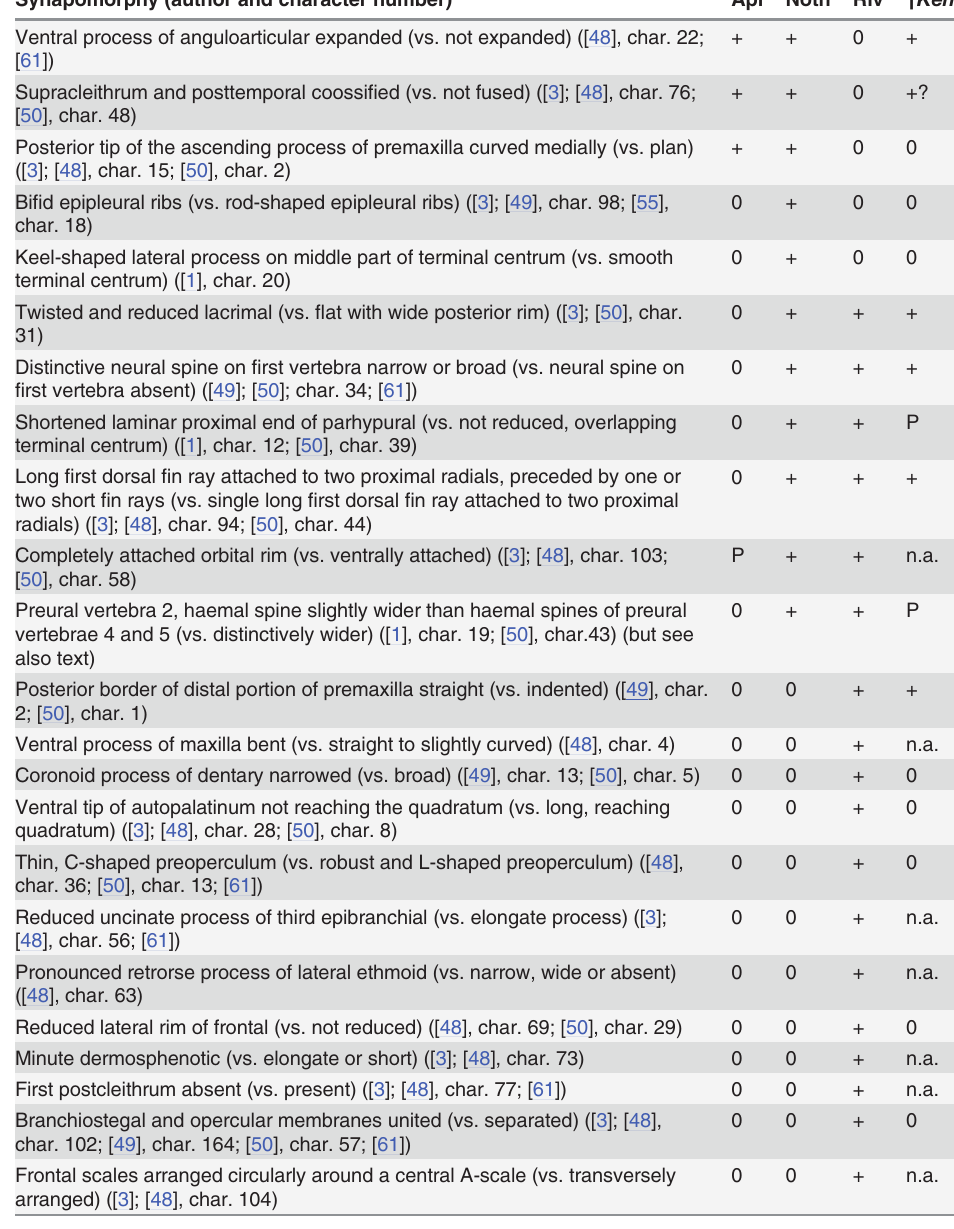
+ + 0 + + + 0 +? + + 0 0 0 + 0 0 0 + 0 0 0 + + + 0 + + + 0 + + P 0 + + + P + + n.a. 0 + + P 0 0 + + 0 0 + 0 0 0 + 0 0 0 + n.a. 0 0 + n.a. 0 0 + 0 0 0 + n.a.